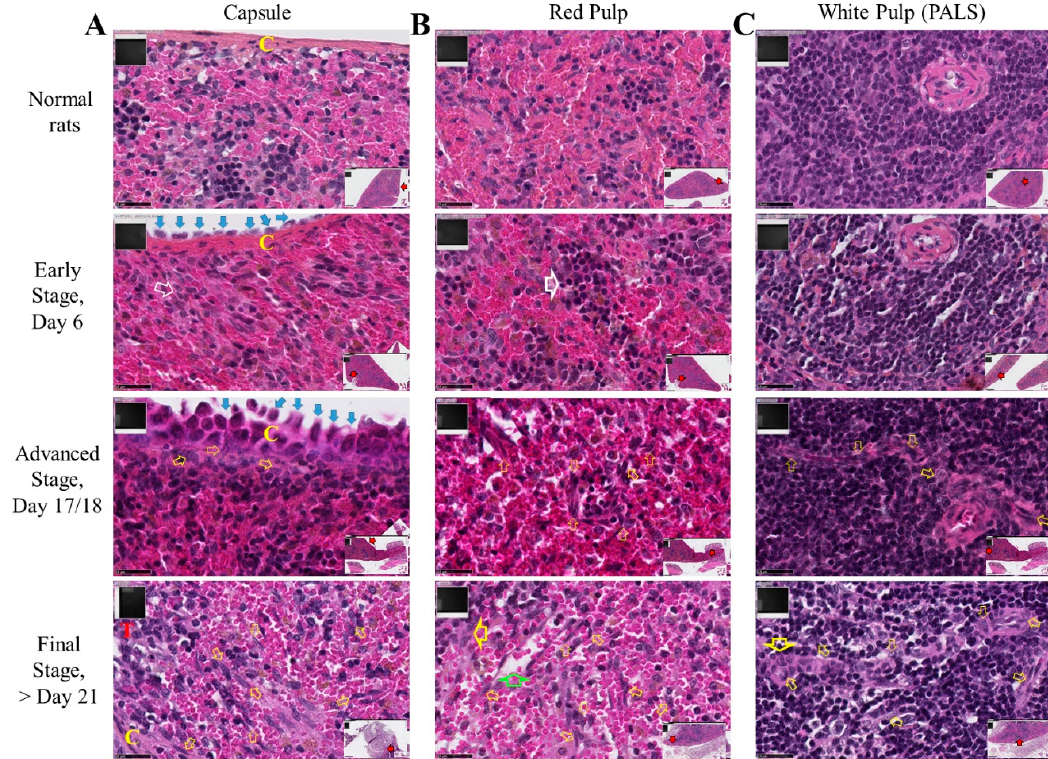
Figure 5. Spleen colonization by M5-T1 cells. High magnification views of the successive stages ( × 800). Scale bars represent 25 µ m, inserts showing general views ( × 25). ( A ) Invasion of the capsule (C, in yellow). The open white arrow shows clustering of reticular cells. Open yellow arrows indicate M5-T1 tumor cells crossing the capsule or present in the red pulp. Vicinal tumor, T in red. ( B ) Red pulp. Early stage: the architecture of the red pulp is preserved, large open white arrow indicating clusters of lymphoid cells on the tumor side attached to the spleen surface. Advanced stage and onwards: open yellow arrows indicate numerous tumor cells actively moving inside the red pulp. Final stage: the large green arrow shows empty spaces, attesting a decrease in the density of normal cells. The large yellow arrow indicates clusters of lymphoid and tumor cells. ( C ) White pulp, periarteriolar lymphoid sheath (PALS). Early stage: the architecture of the follicle is preserved on this cross-section of the central artery. Advanced stage: open yellow arrows indicate tumor cells penetrating the PALS on this longitudinal section of the central artery. Final stage: tumor cells present everywhere following the destruction of the stromal framework of reticular